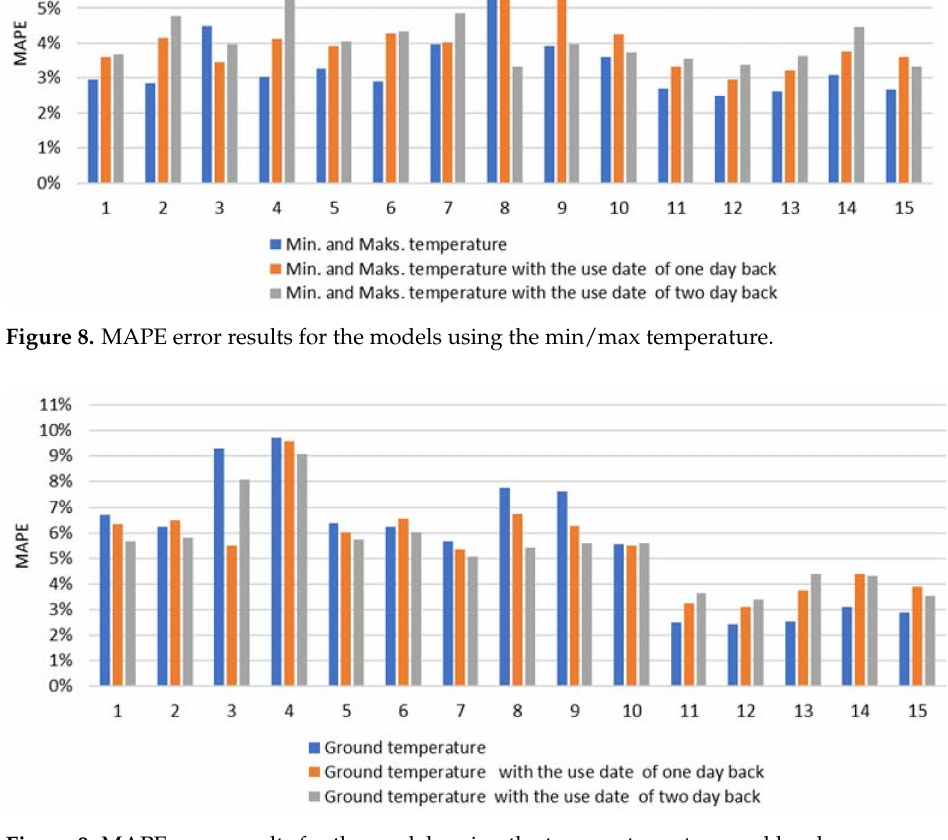
Figure 9. MAPE error results for the models using the temperature at ground level.